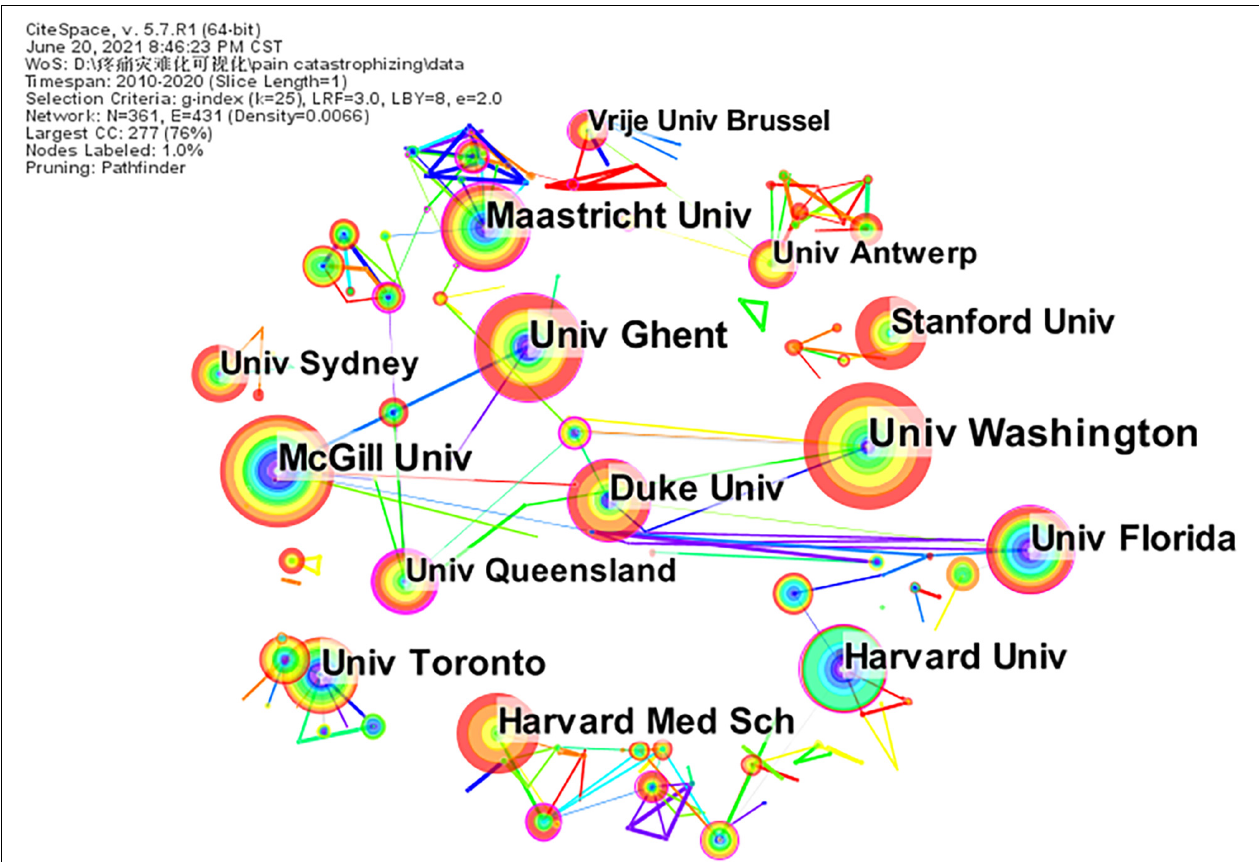
FIGURE 3 | An institution cooperation map related to pain catastrophizing research from 2010 to 2020.